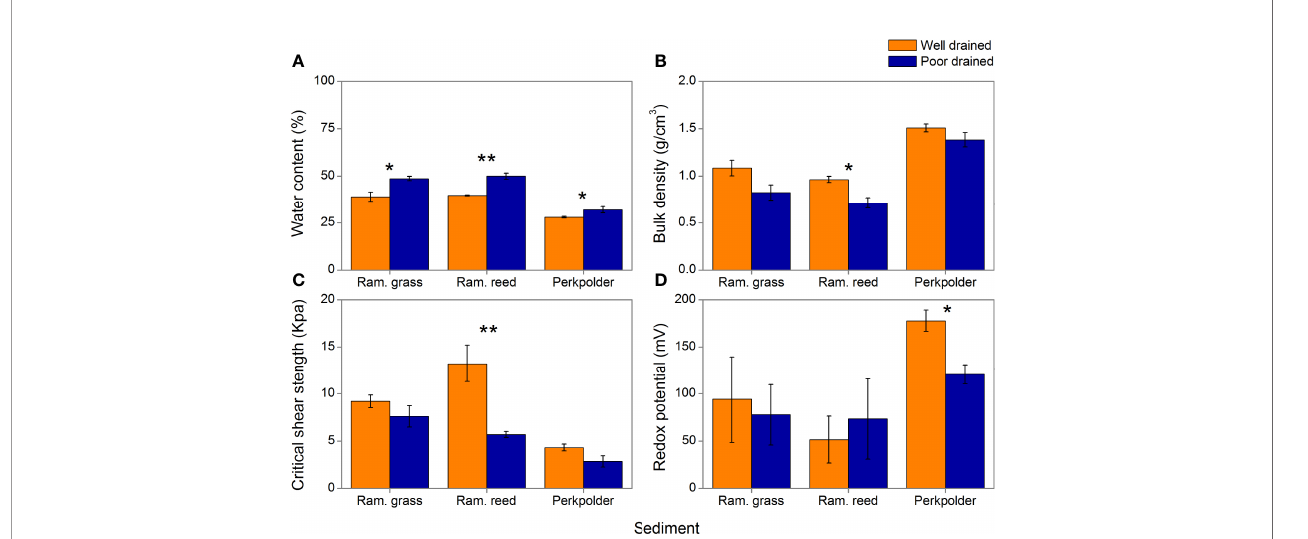
FIGURE 4 | Sediment properties and critical shear stress measured in the mesocosm experiment: (A) water content, (B) bulk density, (C) critical shear stress, (D) redox potential. Colors indicate the same as Figure 2B . (Data is presented as mean + se. Signi fi cance level: *0.05,